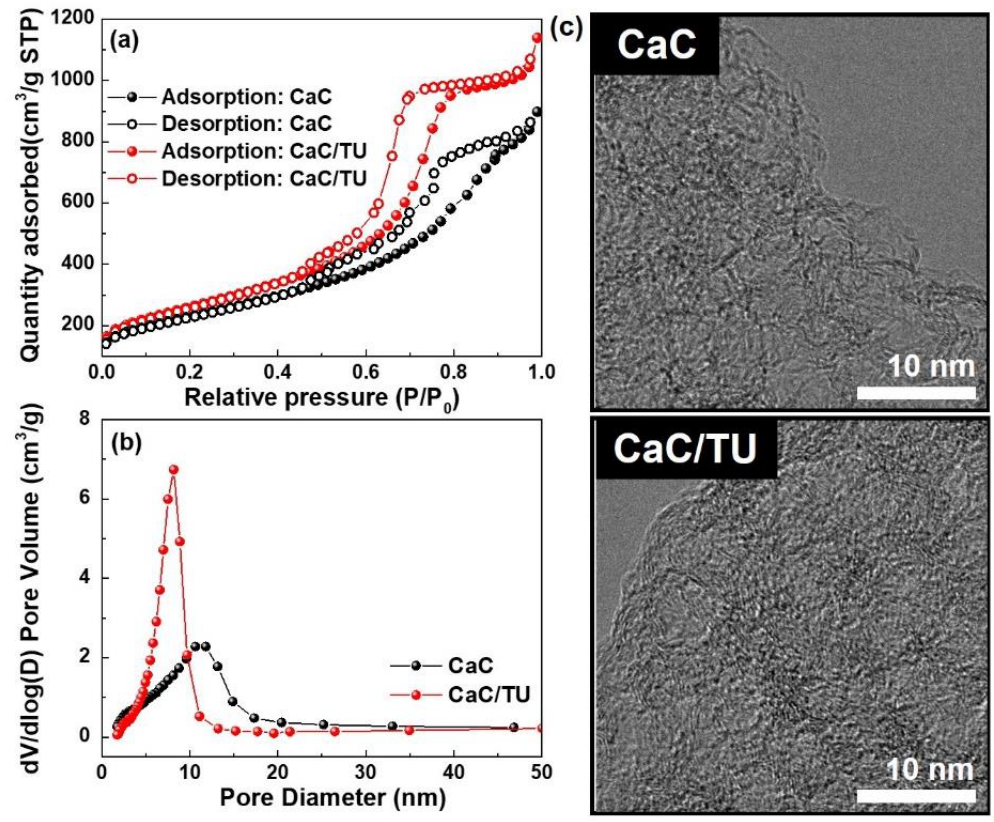
Figure 2. ( a ) Nitrogen adsorption-desorption isotherms and ( b ) BJH pore size distributions of the mesoporous carbon CaC (carbonized calcium citrate) and CaC / TU (with thiourea). ( c ) Transmission electron micrographs of the CaC and CaC / TU powders at high magnification. Table 1. Textural properties of the mesoporous carbon.